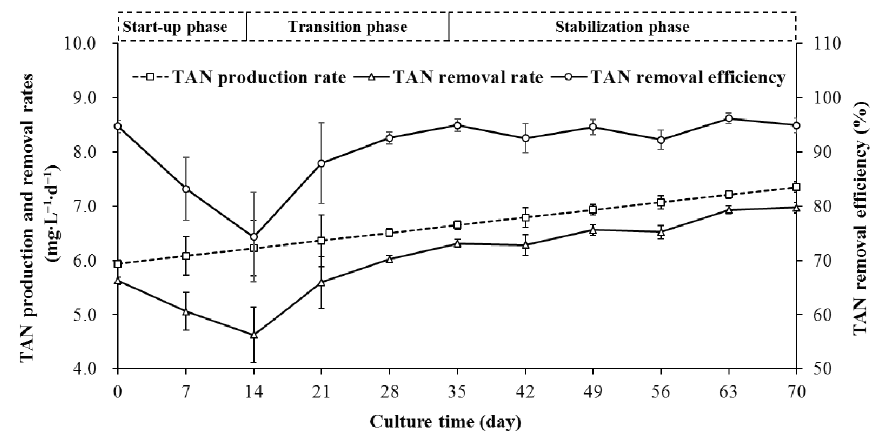
Figure 7. Variation in the production rate, removal rate, and removal efficiency of TAN in shrimp culture tanks of the biofloc-RAS in a 70-day production trial (mean ± S.D., N = 3).